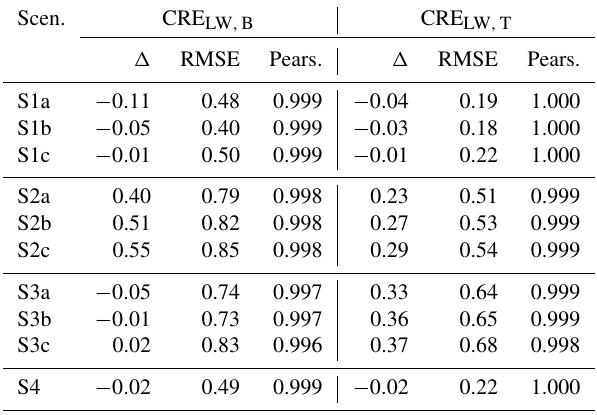
Table C1. Mean CRE (Wm − 2 ) for the LW radiation. Results are given as differences between the new scenario and the reference simulation ( (cid:49) ). The RMSE in Wm − 2 and the Pearson (Pears.) cor- relation between the new scenarios and the reference simulation are also